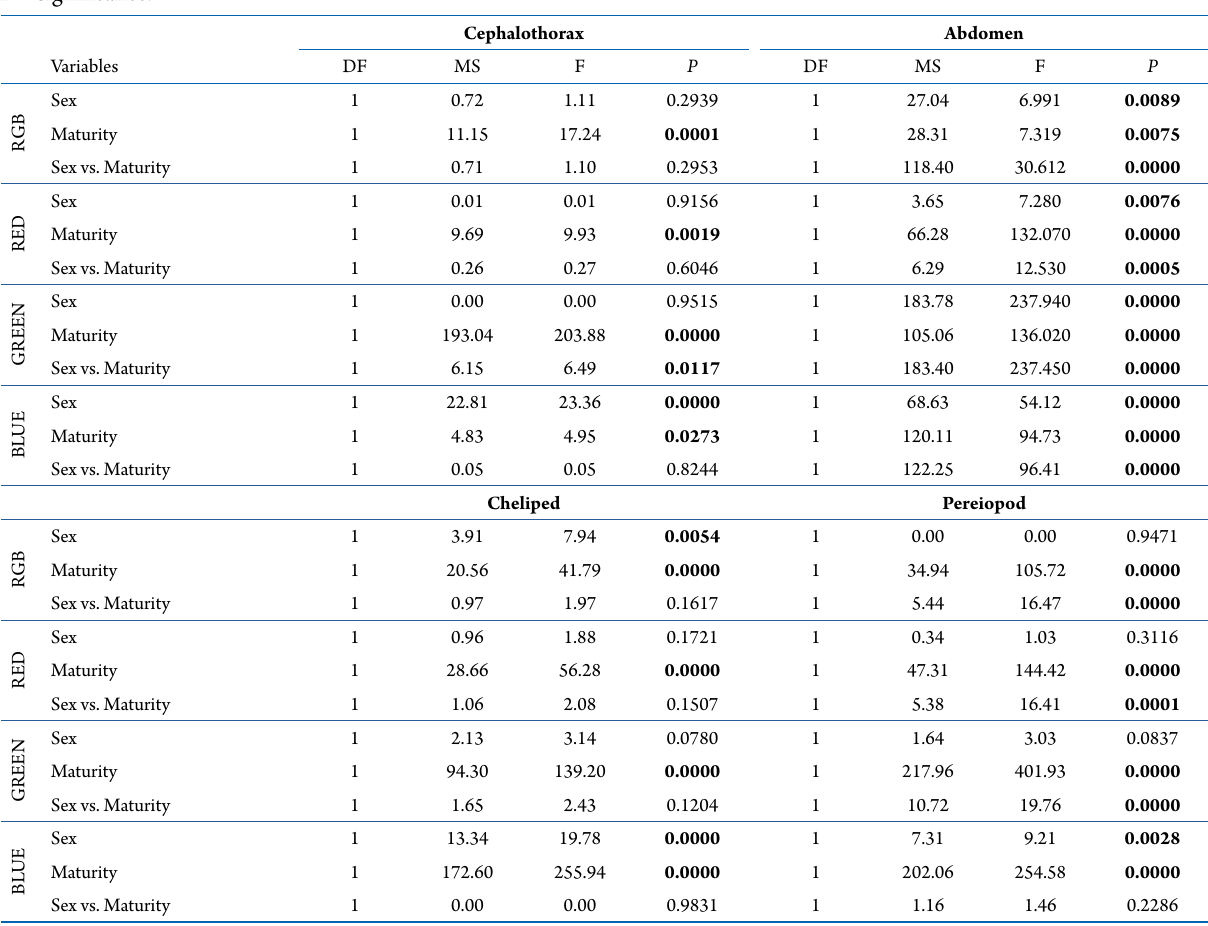
Table 2. Comparison of Dilocarcinus pagei by factorial analysis of variance (ANOVA two-way) of cephalothorax, abdomen, cheliped and pereiopod by color spectrum (red, blue, green and RGB). DF = Degrees of freedom; MS = mean square; F = test value F; P = significance.